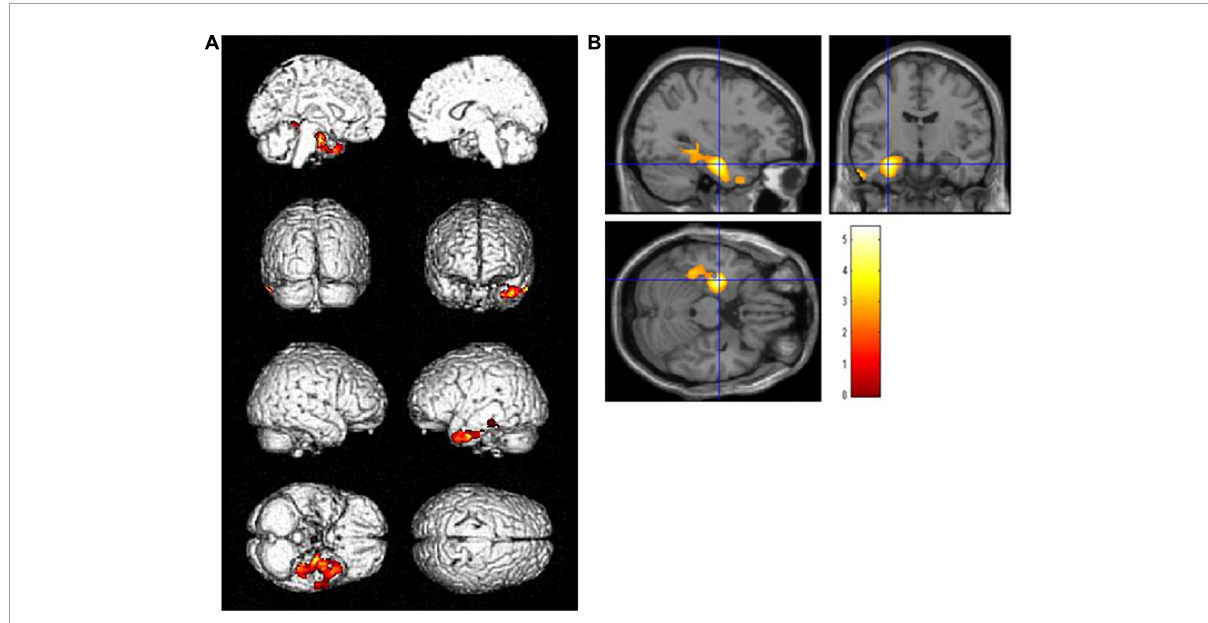
FIGURE1 Regions with statistically significant decrease ( p < 0.01, extent threshold > 400) in glucose metabolism PET after adjusting for Alzheimer’s Disease Assessment Scale-Cognitive Component-Japanese version in the high-education group (years of school education ≥ 13, N = 18) compared with the low-education group (years of school education ≤ 12, N = 39) on (A) the brain surface projection and (B) multi-planar cross-sectional views. The red-yellow scale indicates the level of statistical significance. The blue crossed lines indicate the maximum peak voxel in the left hippocampus [(–32, –11, –23), T = 5.40].